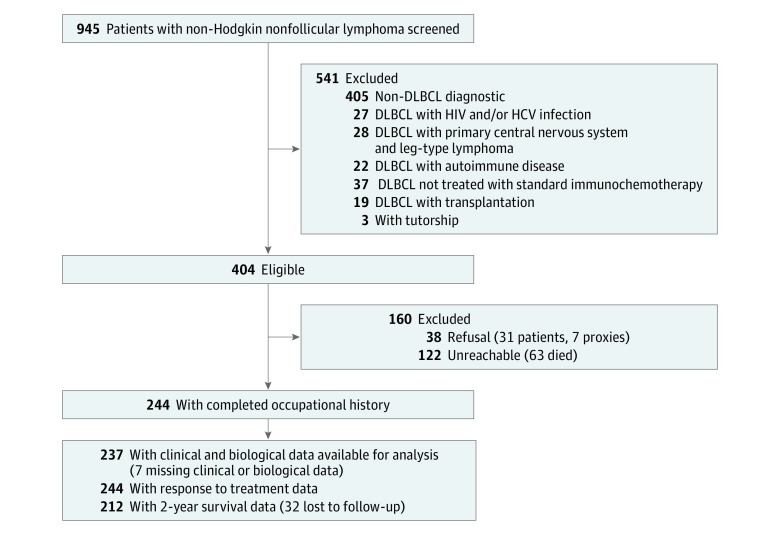
Patient FlowchartDemographic data were missing for 50 patients. DLBCL indicates diffuse large B-cell lymphoma; HCV, hepatitis C virus.